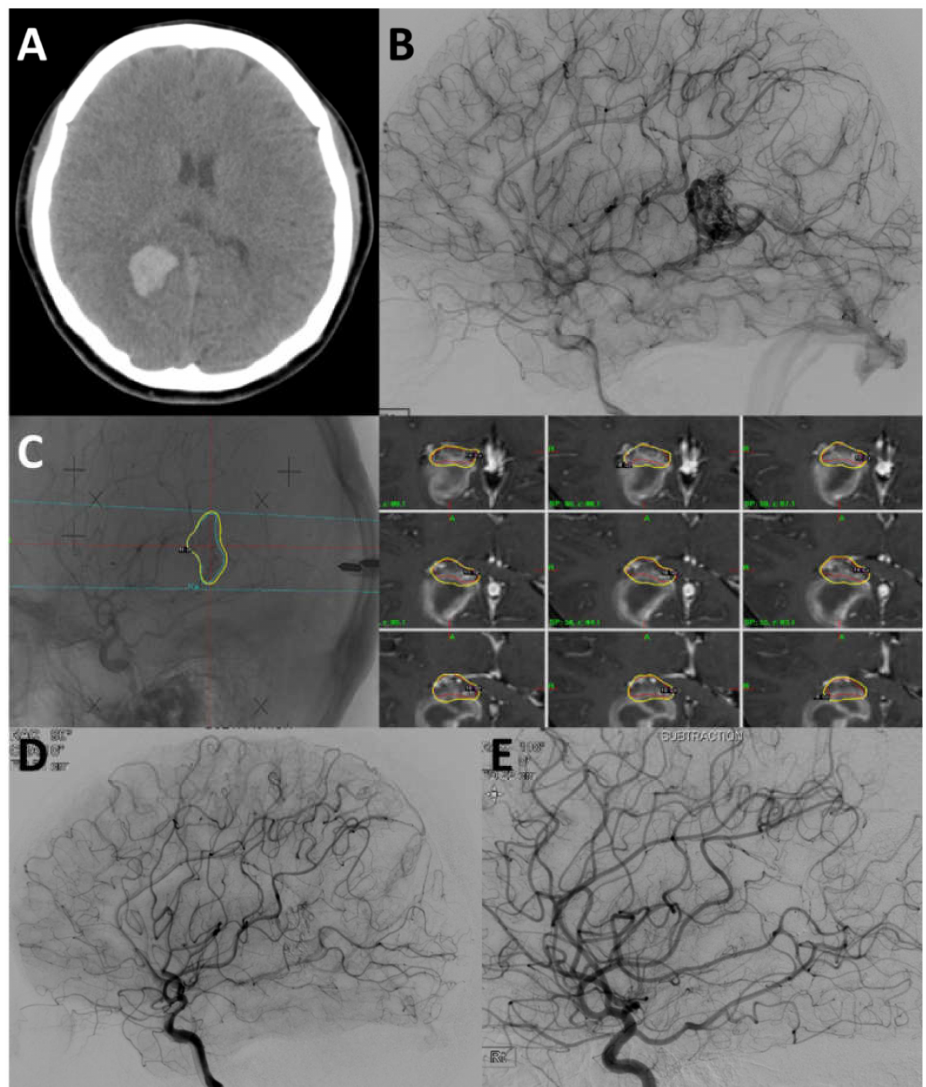
Figure 3. ( A ) The non-contrast enhanced computed tomography revealed an acute intracerebral hemorrhage in the right parieto-occipital lobe. ( B ) The digital subtraction angiography revealed a SM grade II AVM with feeders from the right parieto-occipital and calcarine arteries and draining to the vein of Galen. (C) Gamma knife radiosurgery (2.20 cm 3 , 16 Gy to 50% of the isodense line). ( D ) The final angiogram after NBCA 25% embolization showed near total occlusion of the AVM nidus. ( E ) The digital subtraction angiography (DSA) revealed complete obliteration of the